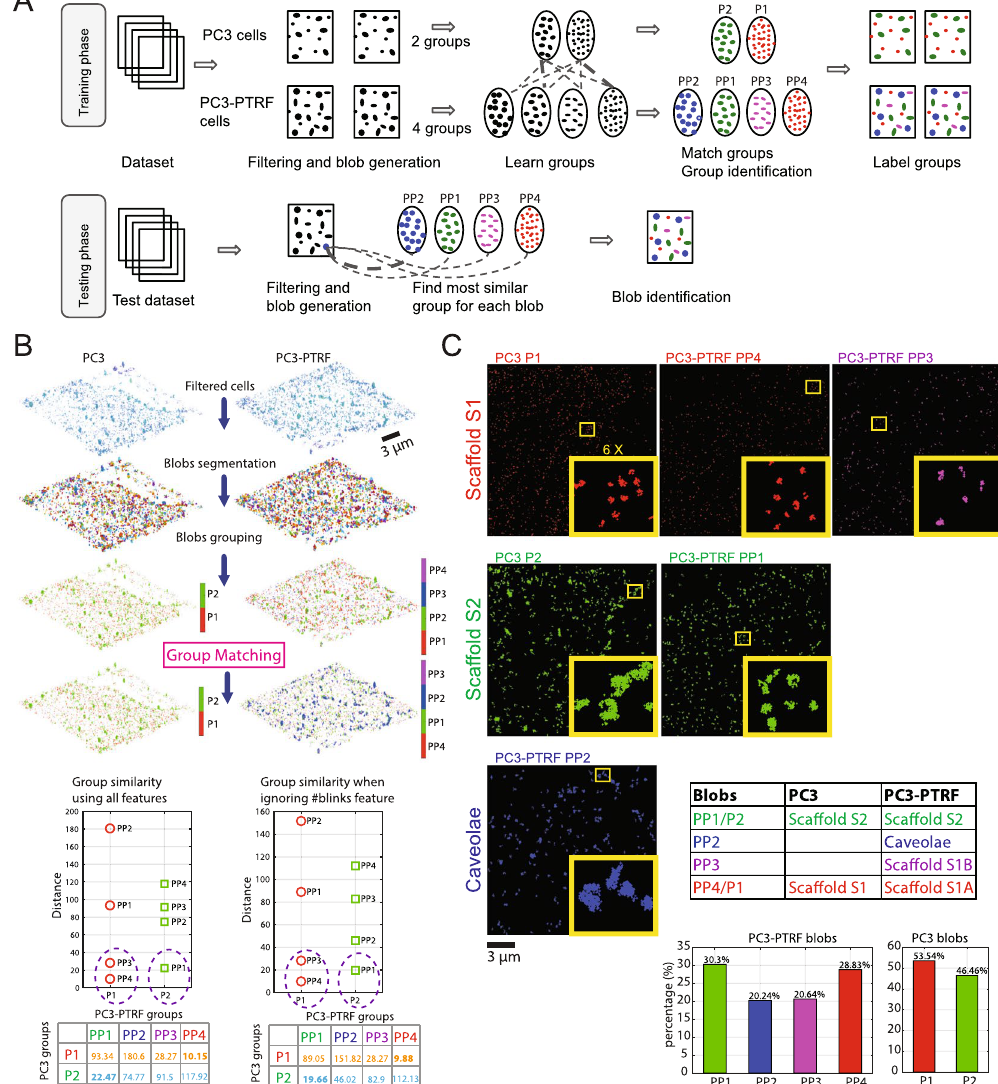
Figure 4. Unsupervised learning identifies different blobs. ( A ) The unsupervised learning framework to build the blob identification model based on datasets. Training phase: we used the cells from both populations of the first three experiments (Fig. 1B) to build the learning model using the unsupervised clustering. The cells are divided into ROIs. A multi-threshold network analysis for each ROI is employed to filter-out the noisy blinks and find the clustered nodes. The blobs are generated from the clustered nodes using the mean shift algorithm. A new set of features are extracted from each blob and fed into the unsupervised clustering (X-means) to learn the different groups. The groups from PC3 and PC3-PTRF populations are matched using the similarity analysis to identify the groups’ types. The matched groups are used to label the blobs on the cells. Testing phase: we used the built model to identify the blobs of the cells from experiment 4. The cell is passed via the space division to get the ROIs. The multi-threshold analysis is applied to filter-out the noisy blinks and return the clustered nodes. The blobs are generated using the mean shift algorithm. The same set of features is extracted for each blob. Each blob feature vector is tested against the centroid feature vector of the learned groups. The closest distance is the most similar group to this blob. The blobs are finally labeled based on the similarity of their feature vector with groups’ centroids. ( B ) After filtering, blob-level feature analysis and segmentation identifies 2 groups (P1, P2) in PC3 and 4 groups (PP1, PP2, PP3, PP4) in PC3-PTRF by unsupervised learning. One-to-one group matching (box) with distances among feature vector of groups centers used as the similarity measure (closer groups are more similar). ( C ) Each group of blobs (S1 or S2 scaffolds or caveolae) is extracted and shown as different channels. Graph shows percent distribution of blobs in PC3-PTRF and PC3